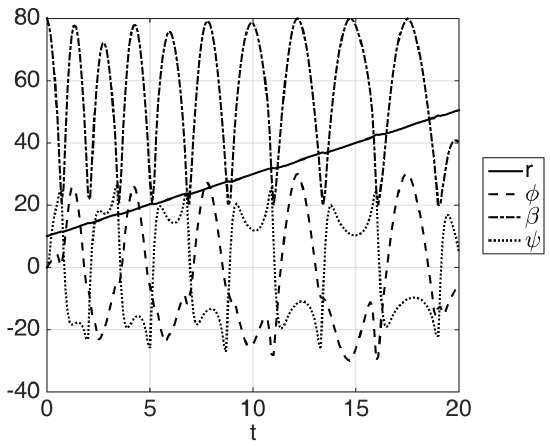
Figure 9. State variables.